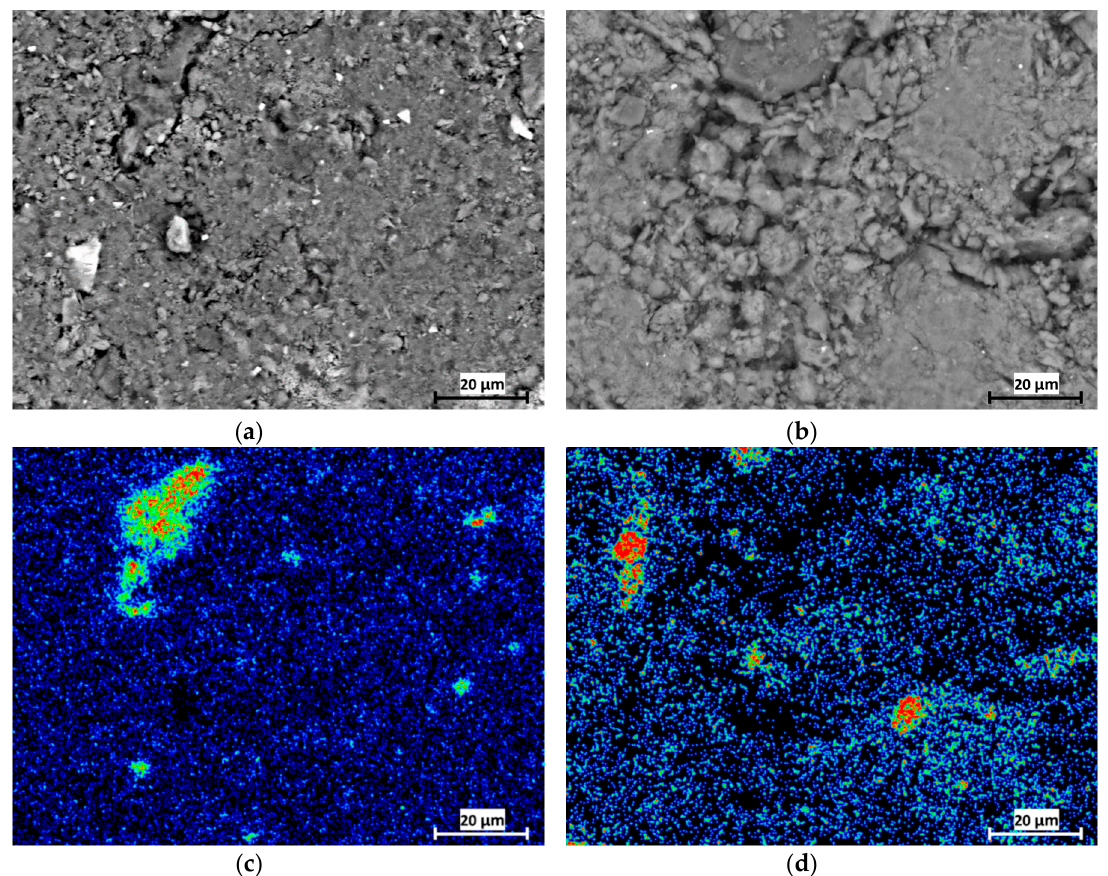
Figure 6. ( a ) and ( b ) are backscattered images of sherds 569 and 514-1, respectively; ( c ) and ( d ) are energy dispersive X-ray spectroscopy (EDS) maps of Na signal intensity of 569 and 514-1, respectively. Grains with excess of Na can be easily identified.